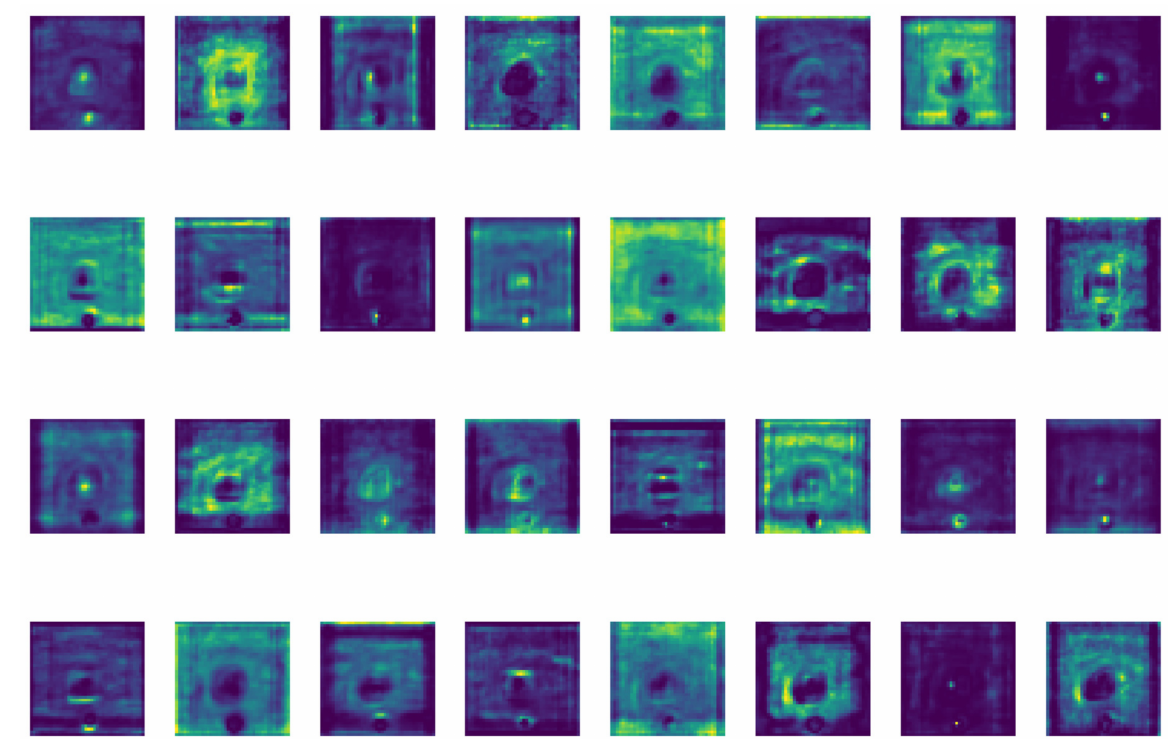
Figure 14. Visualization of the Attentional Feature fusion